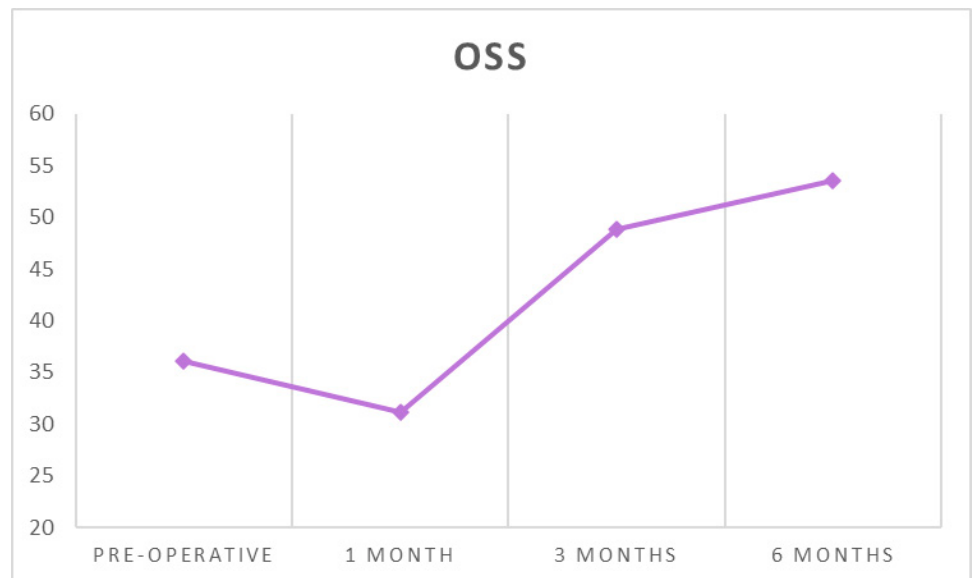
Figure 4. The average ASES at each follow-up timepoint.